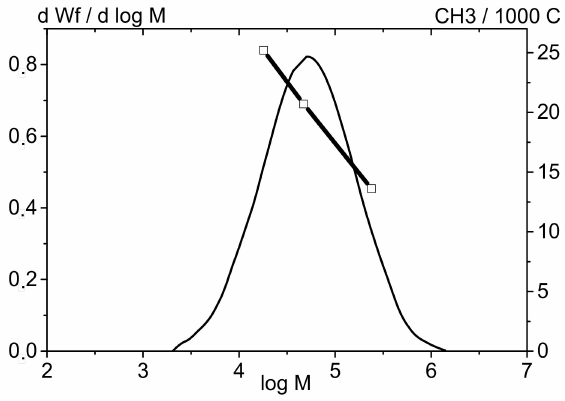
Figure 7. The curves showing molecular weight distribution (1) and content of the comonomer (1-butene) in LLDPE-1